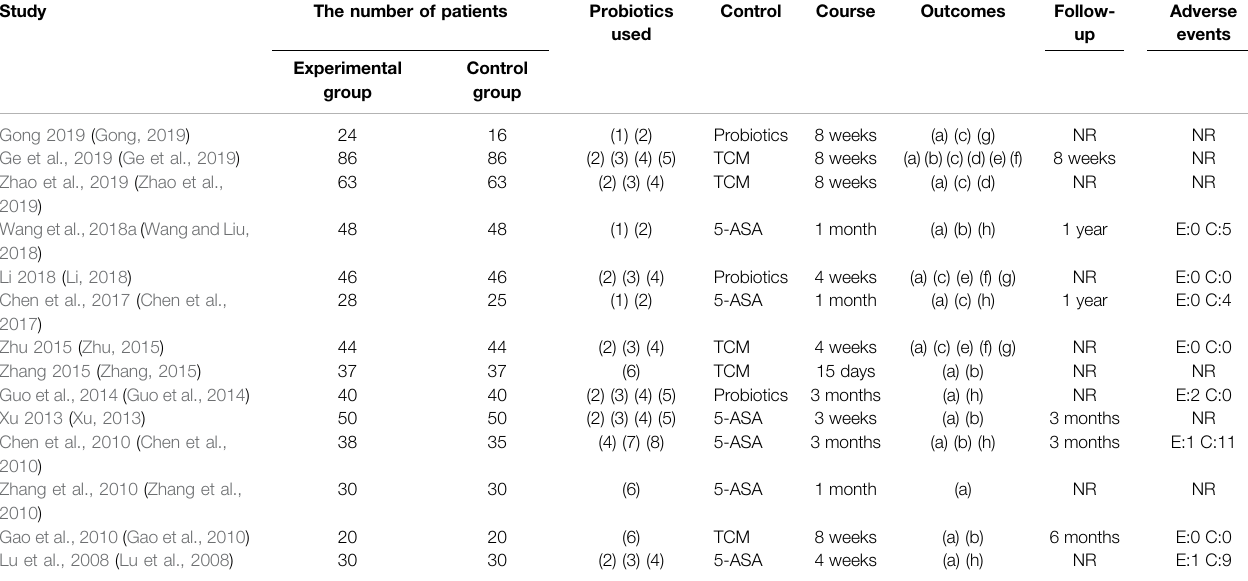
TABLE 1 | The characteristics of included study in this meta-analysis.